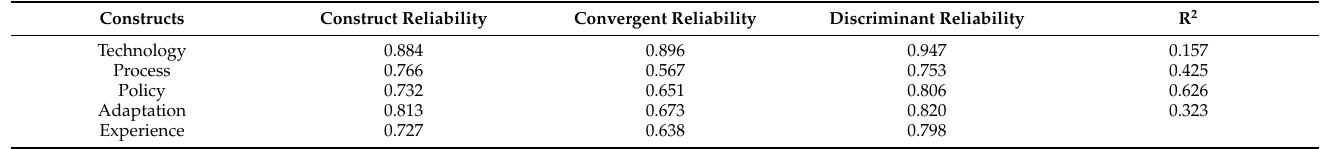
Table 5. Values obtained from the